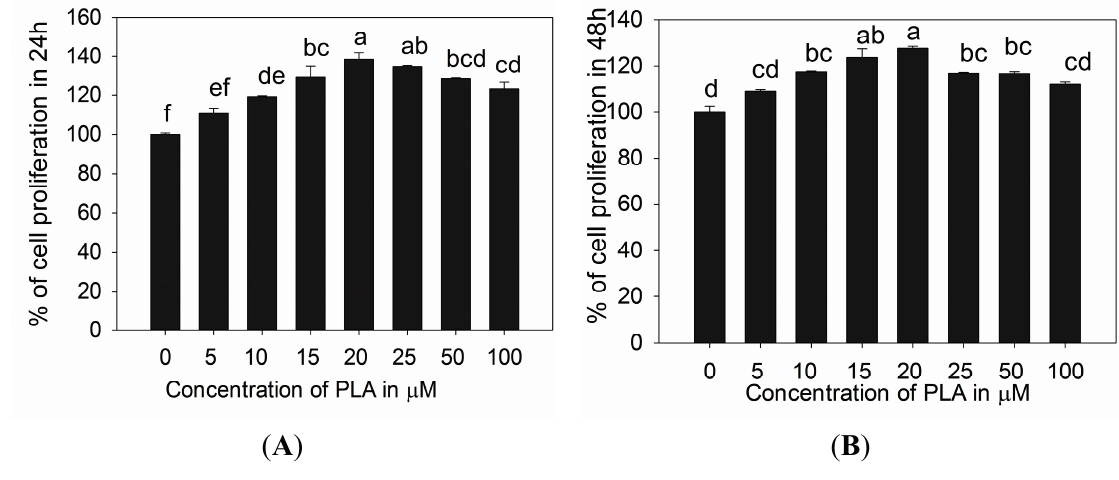
Figure 1. Cell proliferation activity of PLA. It increased cell proliferation in a concentration-dependent manner (5–20 μ M) at 24 ( A ) and 48 h ( B ). Further